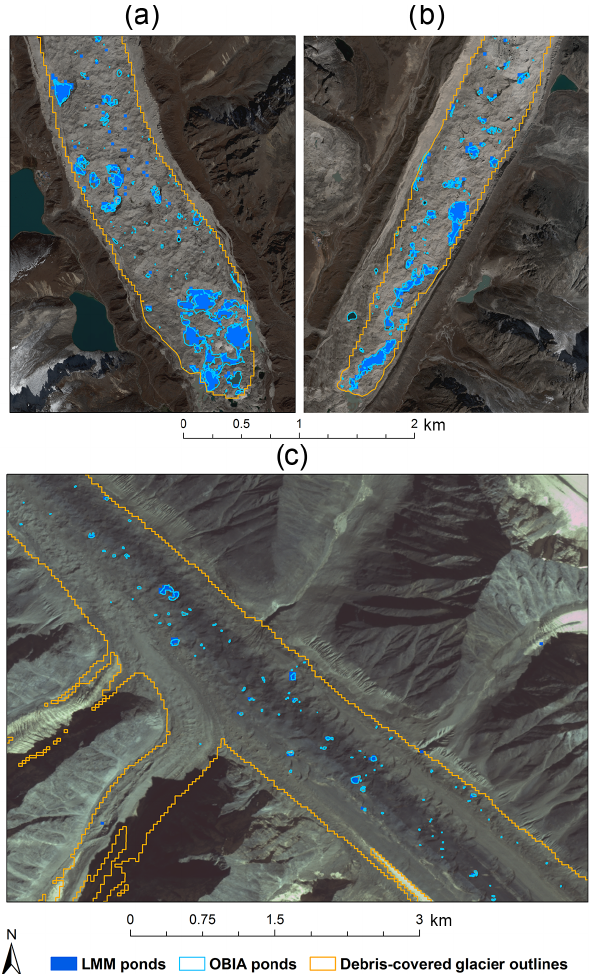
Figure 6. Comparison of the Landsat sub-pixel classified fractional ponds (dark blue) with OBIA pond outlines (light blue) based on high-resolution data for the termini of three glaciers: (a) Ngozumpa Glacier, (b) Khumbu Glacier and (c) Bara Shigri Glacier. The back- ground images are colour composites (bands 1,2,3) of Pléiades im- agery (a, b) and PlanetScope imagery (c) . Glacier outlines are from the SDC dataset (Scherler et al., 2018).